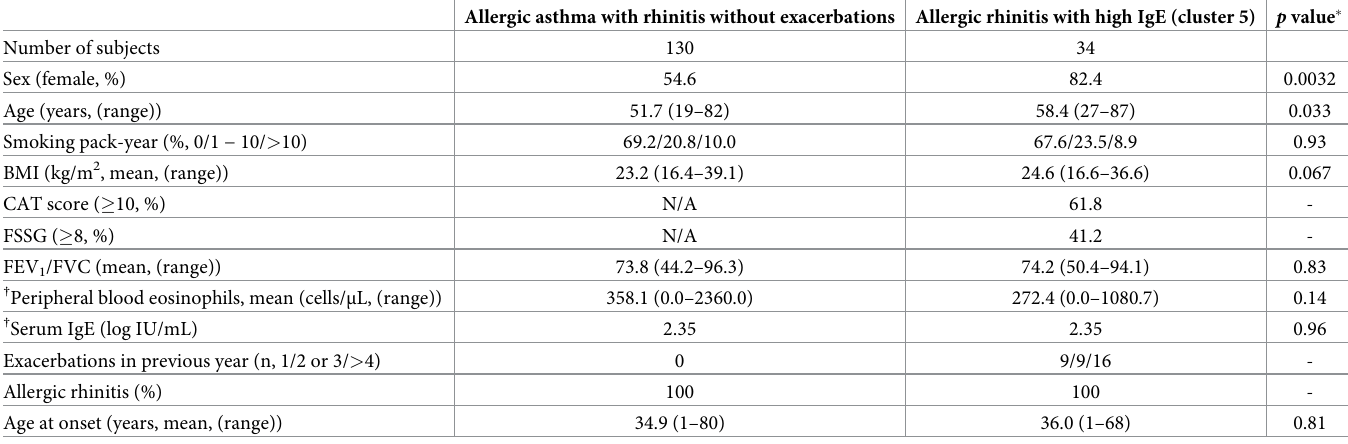
Table 5. Comparisons of the basic characteristics of allergic asthma with rhinitis with and without exacerbations.